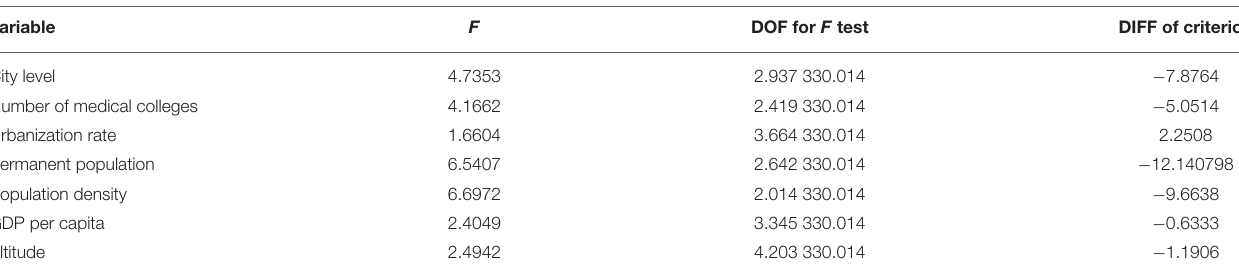
TABLE 5 | Geographical variability tests of local